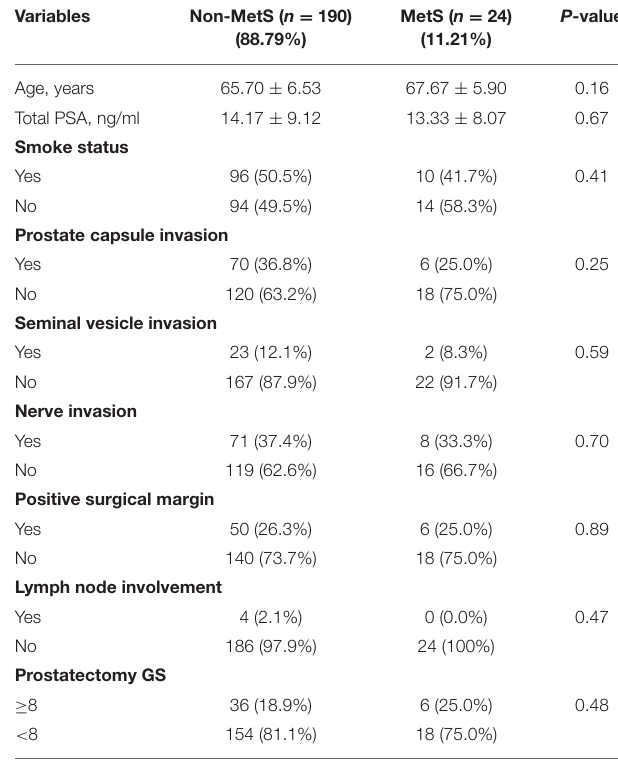
TABLE 1 | Patient characteristics ( n = 214). TABLE 2 | Association between MetS and clinicopathological factors.